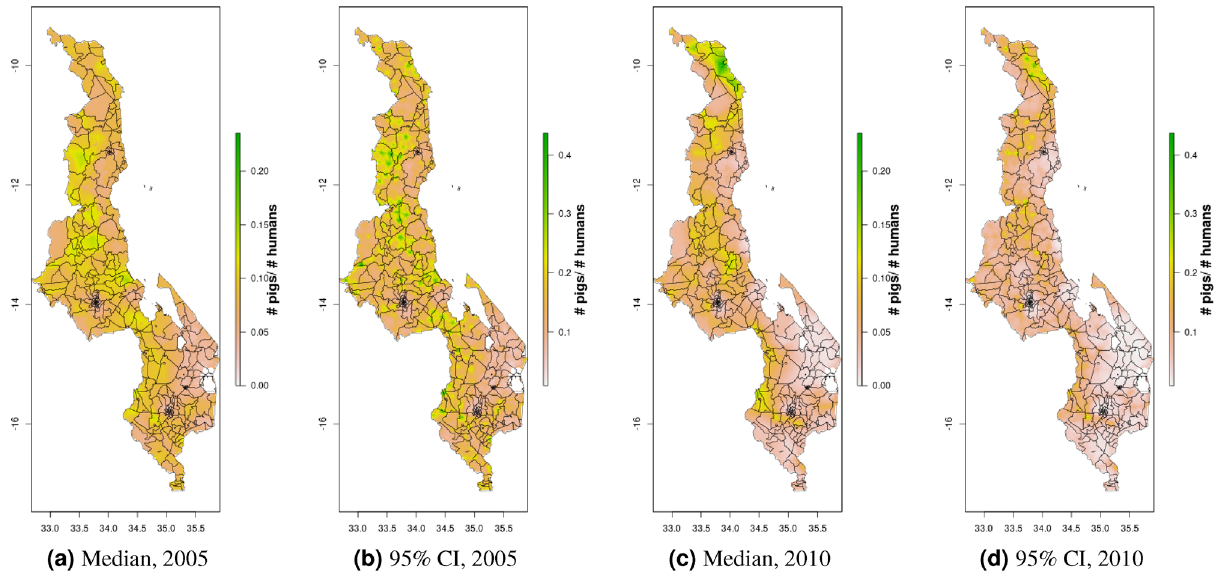
Figure 5. Pig density mapping results, Malawi, 2005 and 2010. Median ( a, c ) and width of posterior 95% credible interval ( b, d